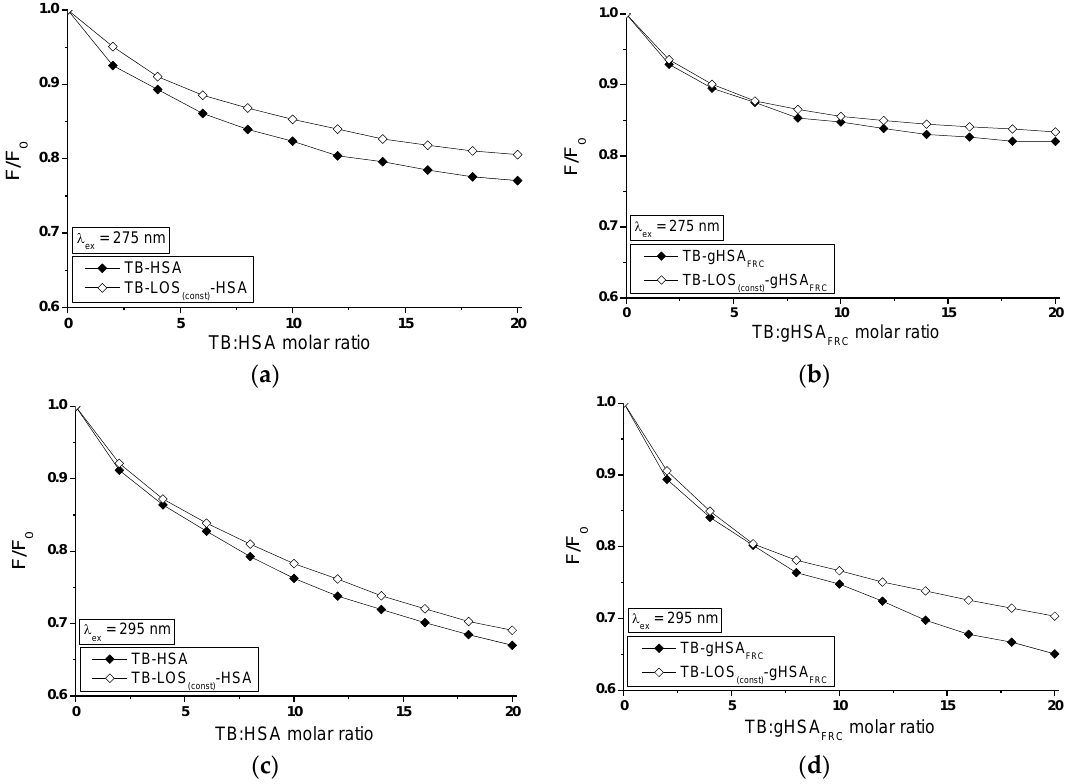
Figure 12. Quenching of HSA and gHSA FRC fluorescence by TB and in the presence of LOS at 5 × 10 −6 mol∙L −1 concentration. TB concentration varied from 1 × 10 −5 –1 × 10 −4 mol∙L −1 . Albumin concentration: 5 × 10 −6 mol∙L −1 ; ( a , b ) λ ex = 275 nm; ( c , d ) λ ex = 295 nm; the error bars are smaller than the symbols.